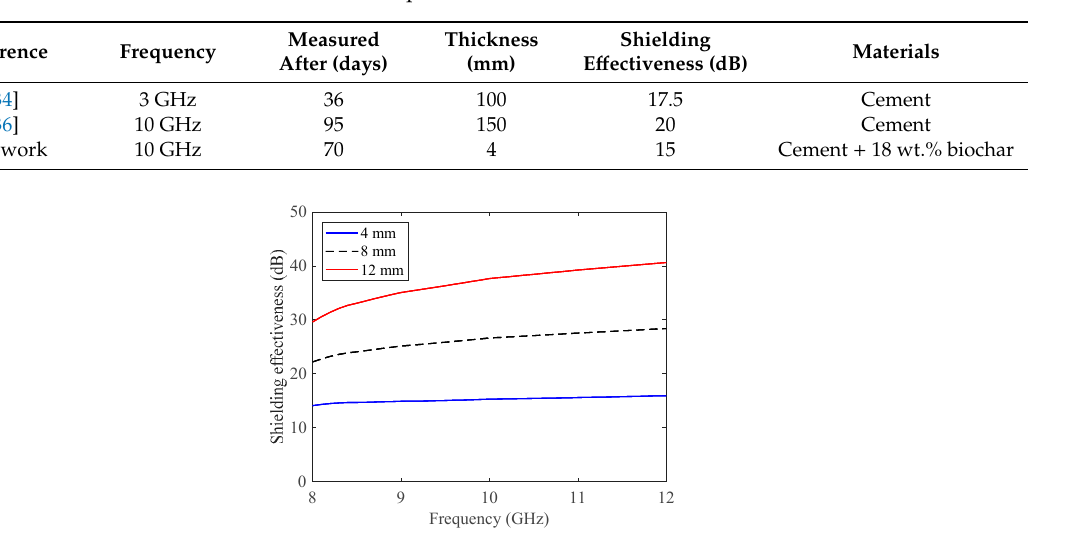
Figure 9. Simulated results for cement composites with 18 wt.% biochar with different thicknesses.